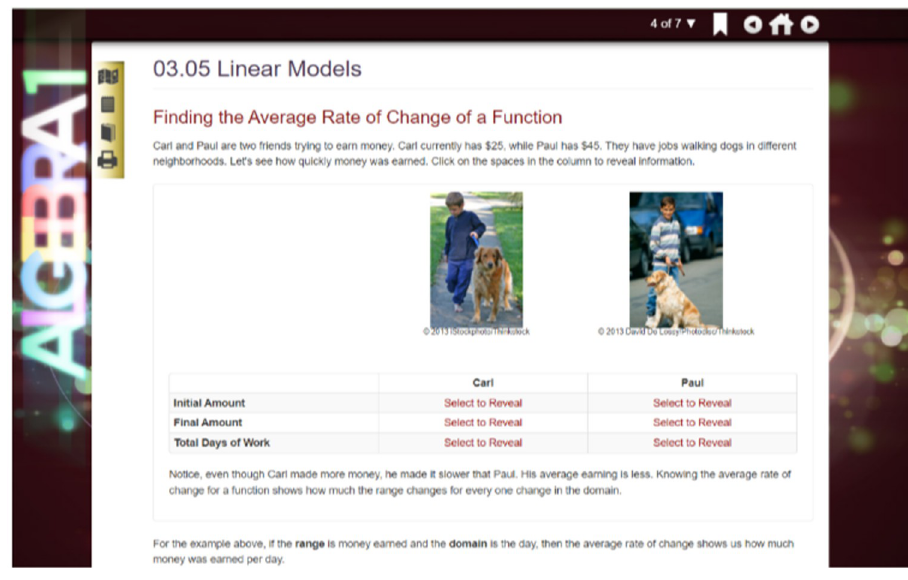
Fig 2. FLVS Algebra 1, interactive guided practice.